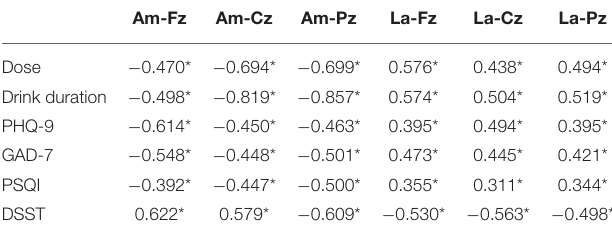
TABLE 2 | The association between ERP data and clinical data by Spearman simple correlation in all included AUD patients by Bonferroni correction ( N =